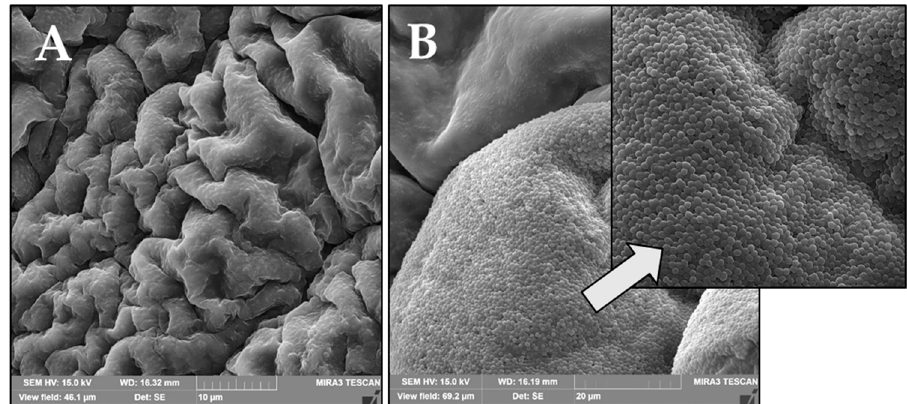
Figure 14. SEM microphotography of bio-hybrid hydrogels: M-T-SA ( A ) and basic matrix (M) ( B